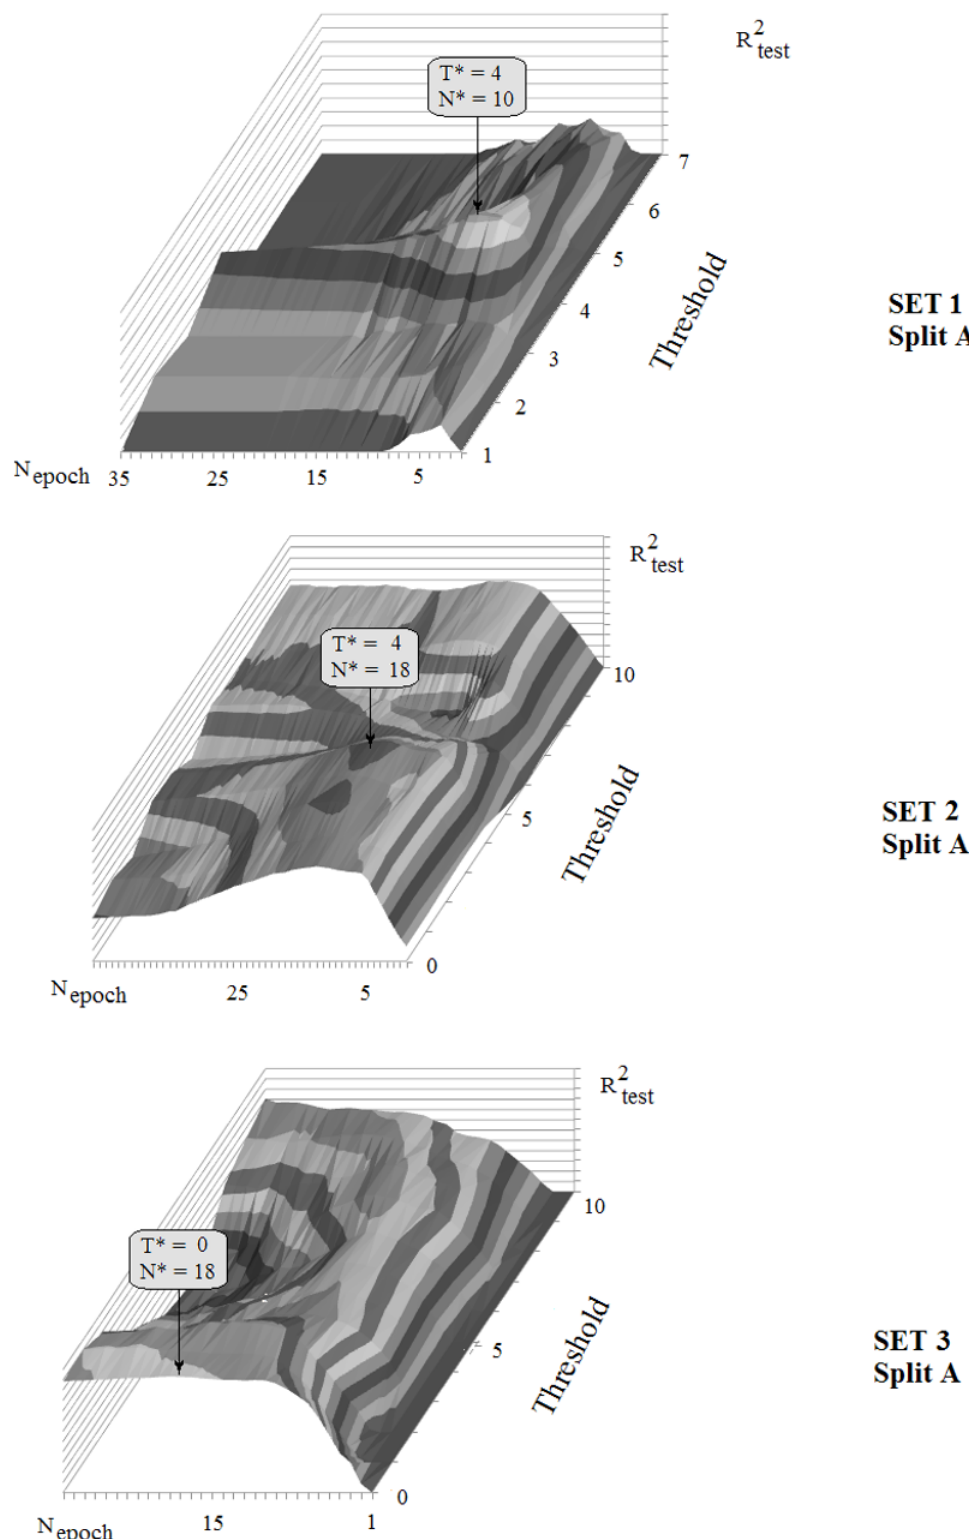
Figure 1. The graphical represenation of the selection of the preferred threshold (T*) and the number of epochs (N*) for SET 1, SET 2, and SET